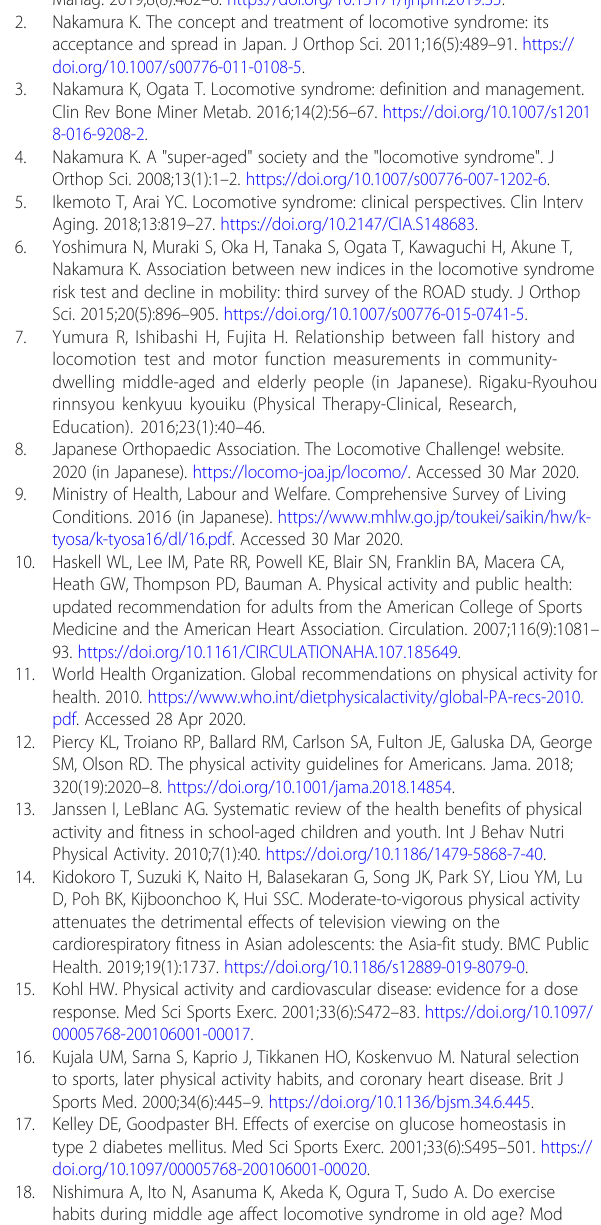
Additional file 1: Supplementary Table 1. Comparison of physical fitness and motor ability test results during university years between low and high cardiovascular intensity